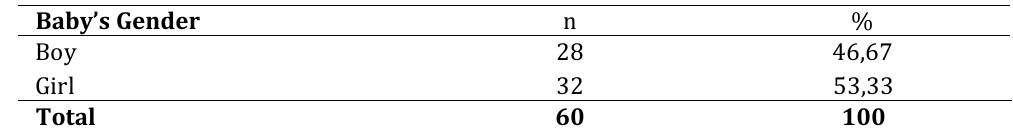
Characteristic respondent that consisted of Baby’s Gender